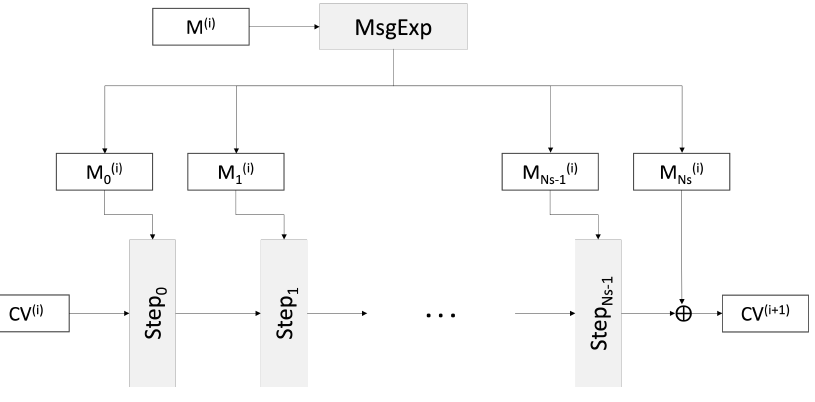
Figure 2. Compression Function (CF) of